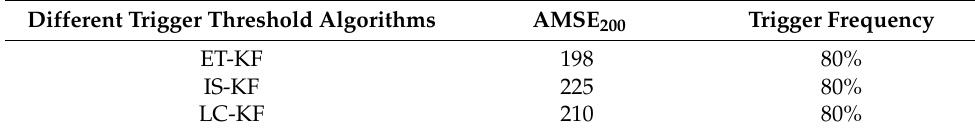
Table 4. The performance comparison of different trigger threshold algorithms. Different Trigger Threshold